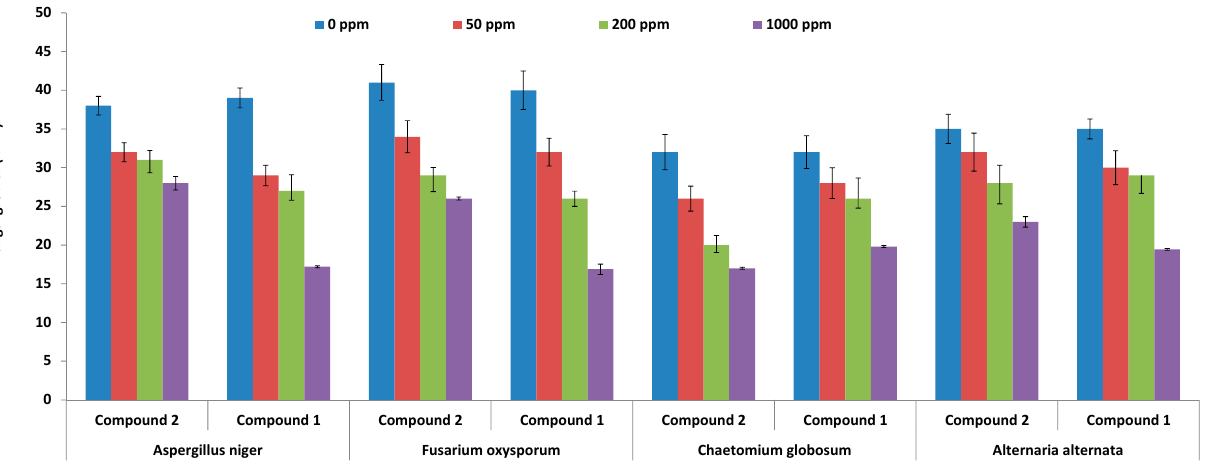
Figure 4. Antifungal activities of compound 1 and 2 against the growth pathogenic fungi. The bars represent the mean values with standard error of three